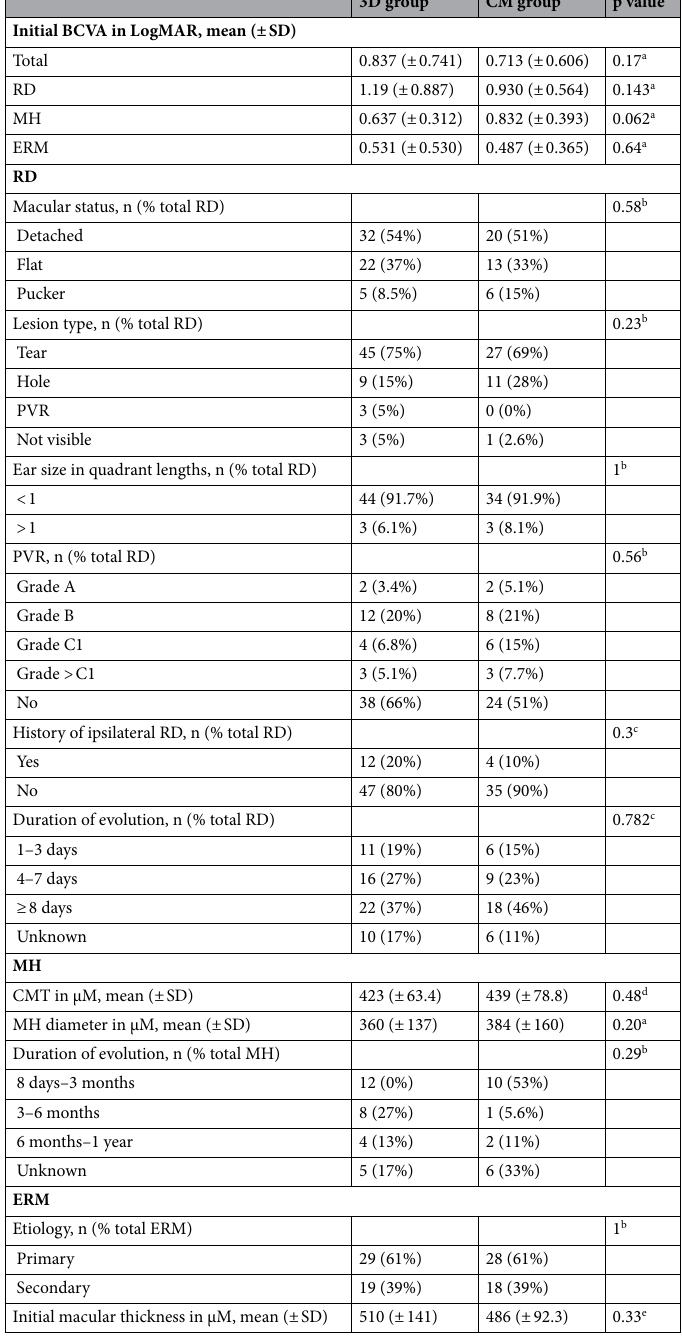
Table 3. Initial anatomical characteristics of patients in the three-dimensional (3D) and conventional microscopy (CM) patient groups. BCVA best corrected visual acuity, CMT central macular thickness, ERM epiretinal membrane, LogMAR logarithm of the minimum angle of resolution, MH macular hole, PVR proliferative vitreoretinopathy, RD retinal detachment, SD standard deviation. a Student’s t-test. b Fisher’s